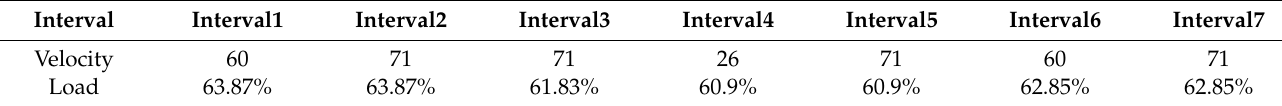
Table 8. Line interval segmentation results.